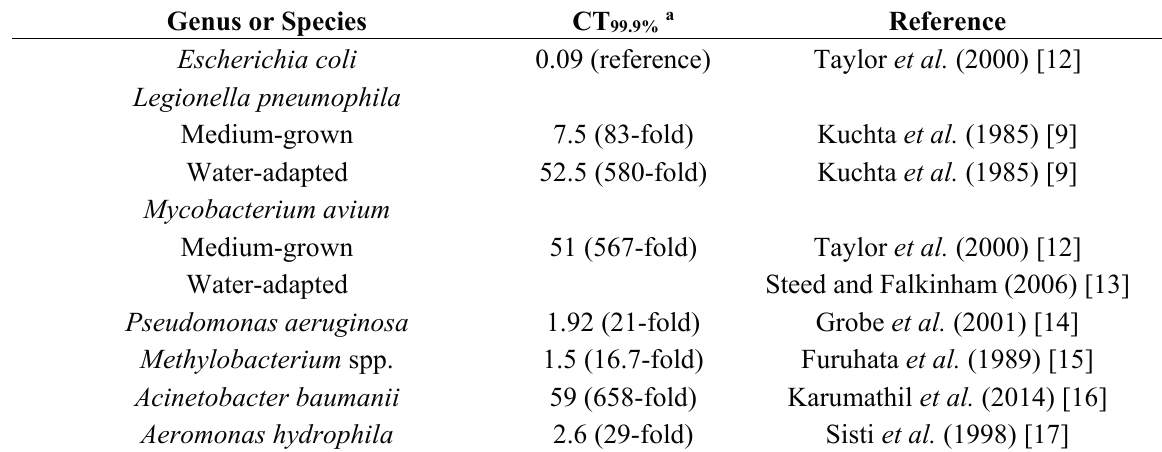
Table 1. Chlorine resistance of waterborne pathogens relative to Escherichia coli